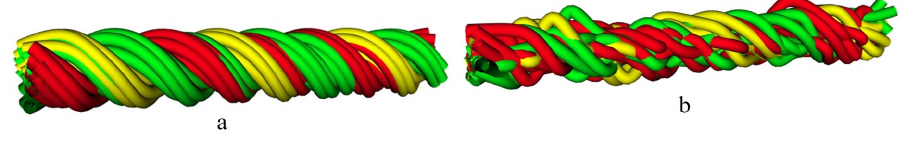
Figure 11. The 3-ply twisted yarn, ( a ) nonrandomised yarn and ( b ) randomised yarn.